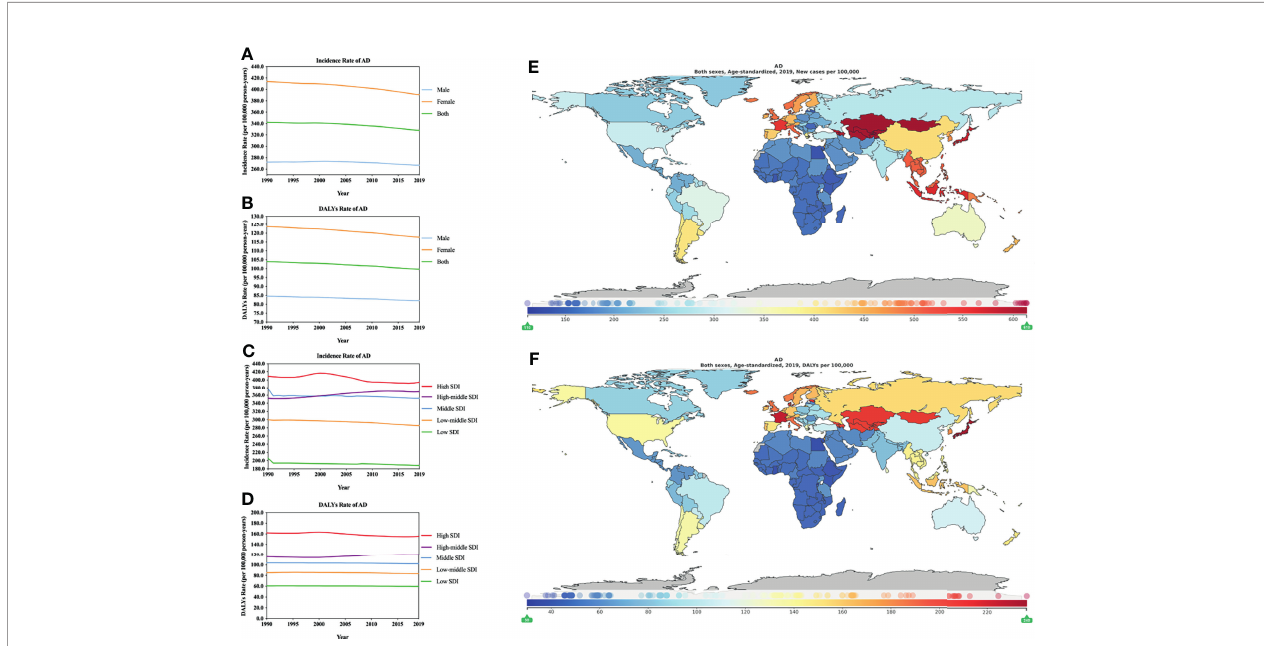
FIGURE 2 | Burden of AD for 204 countries and territories. ASIR ( A , by sex; C , by SDI) and ASDR ( B , by sex; D , by SDI) per 100,000 population of AD (1990 – 2019) by country and region. The distribution of ASIR (E) and ASDR (F) per 100,000 population of AD globally in 2019. (E, F) were generated by